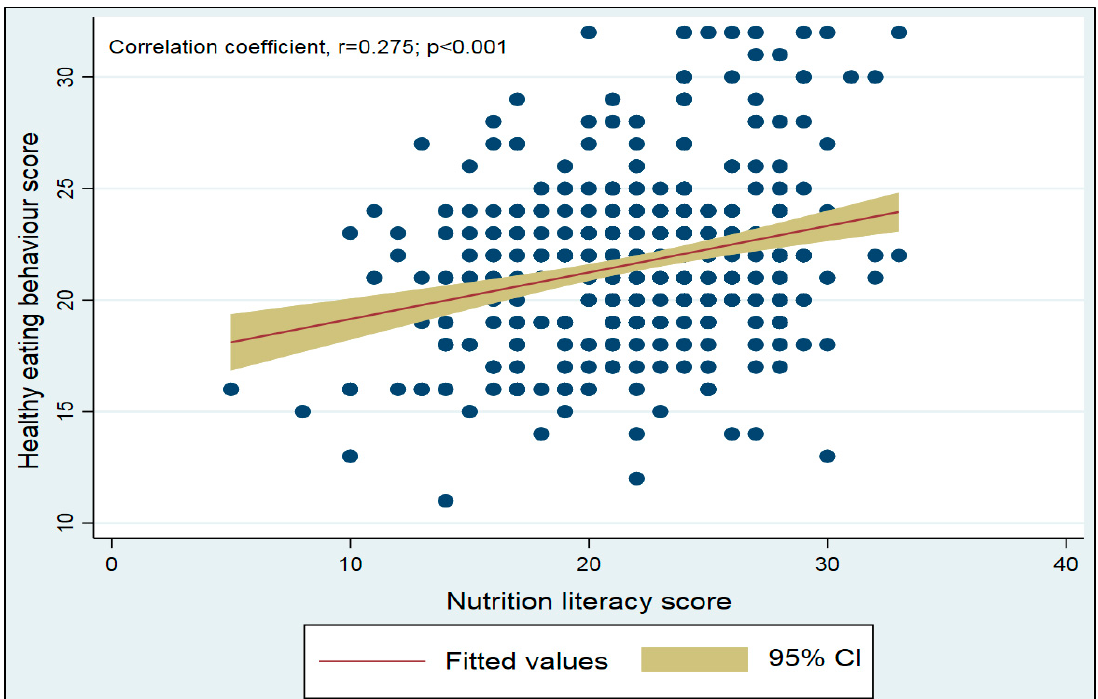
Figure 2. Scatter plot showing the correlation between healthy eating behavior scores and nutrition